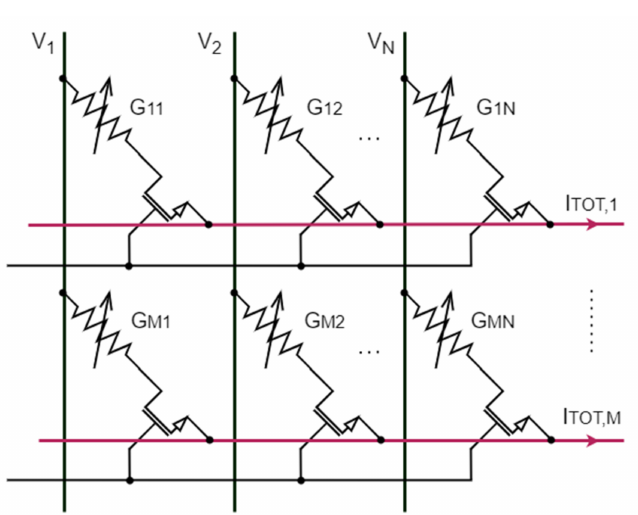
Figure 1. Schematic diagram of a phase-change memory (PCM) array and its use for analog in- memory computing